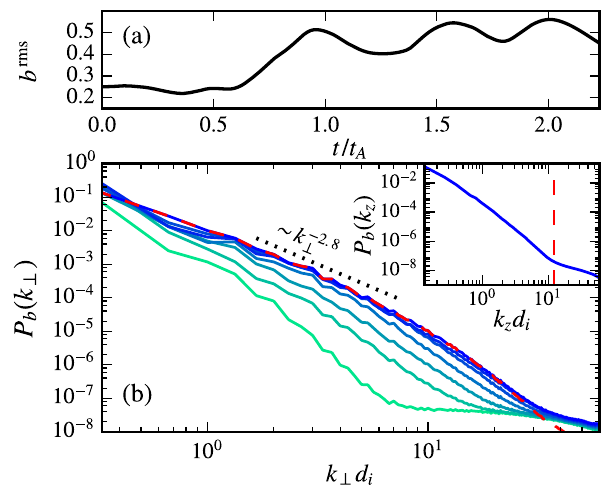
FIG. 1. Time trace of the root-mean-square fluctuating mag- netic field (a) and the 1D k ⊥ magnetic spectra (b) at times t=t A ¼ f 0 . 66 ; 0 . 92 ; 1 . 18 ; 1 . 45 ; 1 . 71 ; 1 . 97 ; 2 . 24 g in the simulation (light green to dark blue). A − 2 . 8 slope is shown for reference (dotted line). The inset shows the k spectrum. Particle noise dominated z d > 12 (vertical dashed line) are filtered out in the modes with k FIG. 2. Local anisotropy of the externally driven turbulence (a) z i 2 . 24 subsequent analysis. The k and the ratio of linear to nonlinear timescales (b). A 1 = 3 slope in filtered k ⊥ spectrum at t=t z A ¼ (a) is shown for reference. All components of the magnetic field is shown with a red dashed line in (b). All components of the were normalized to B 0 in the magnetic field are normalized here to B 0 .